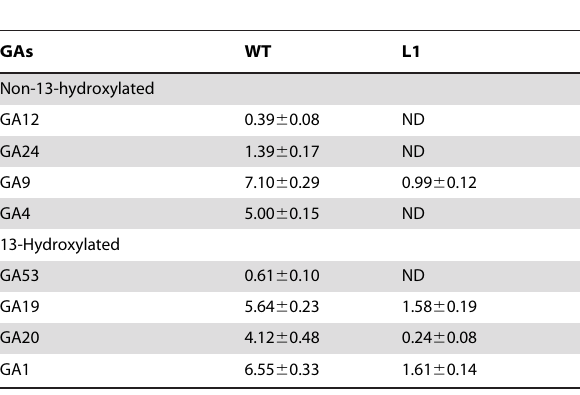
Table 2. The bioactive GAs contents in transgenic and WT